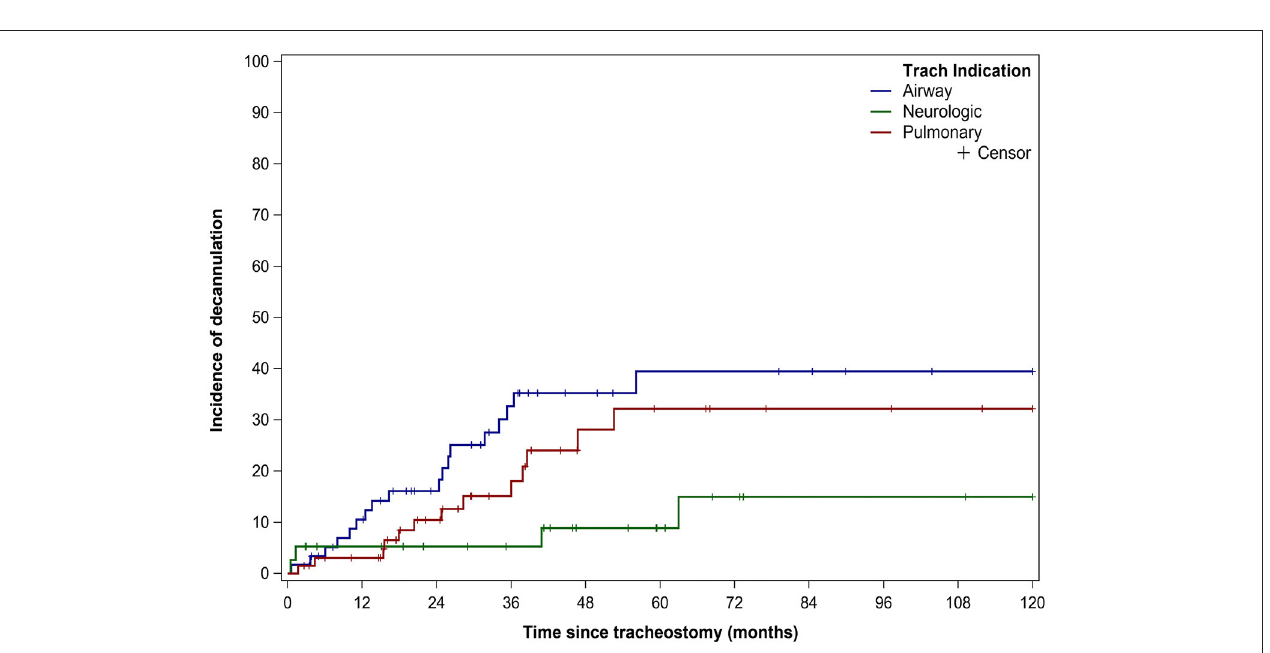
FIGURE 3 | Time from tracheostomy to decannulation for the entire cohort. CIF Est, Cumulative incidence function estimates; CI, confidence interval.